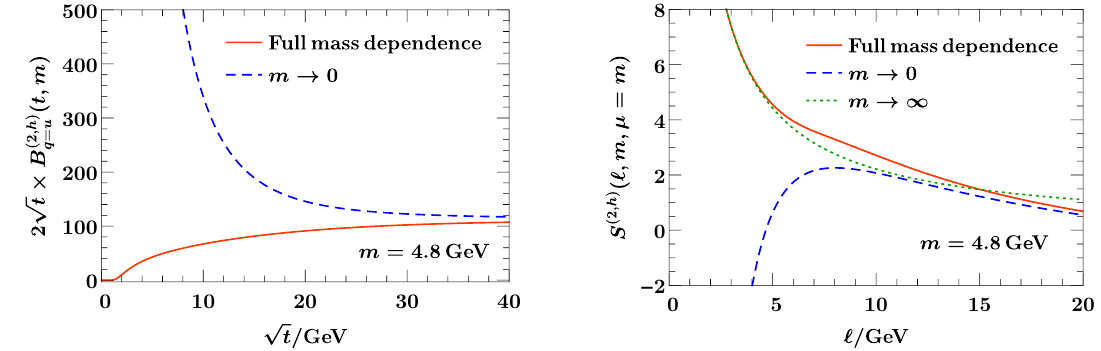
Figure 15 . Secondary massive b -quark corrections to the u -quark beam function for Y = 0 (left panel) and the soft function (right panel) at and ‘ , (cid:24) T